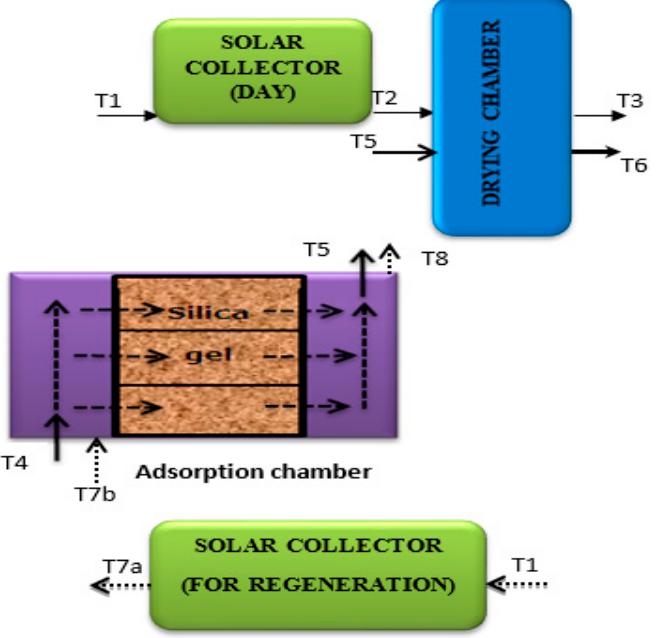
Figure 2. Solar-adsorbent dryer system (SADS) showing locations of K-type thermocouple for the temperature measurement (T1-T8) at input and output of each unit.